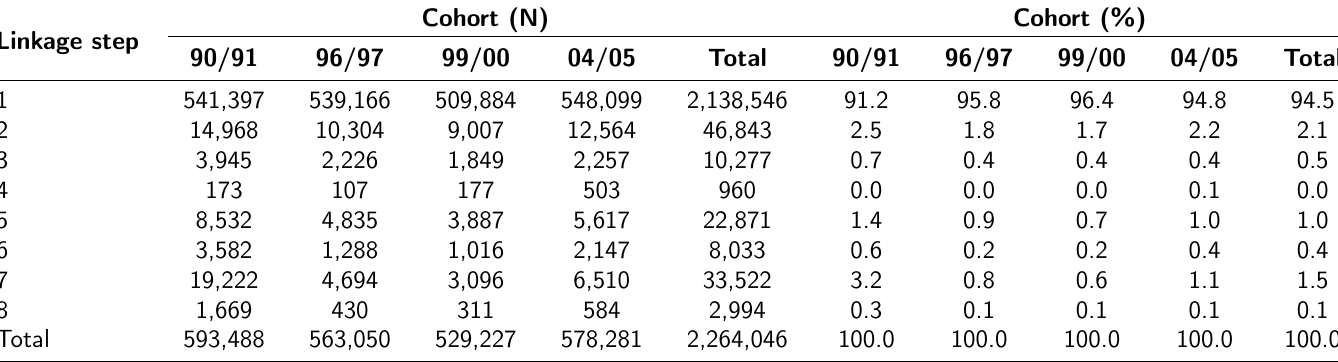
Supplementary Table 6.1: Linkage national pupil dataset to personal demographics service by linkage step and cohort (all pairs)